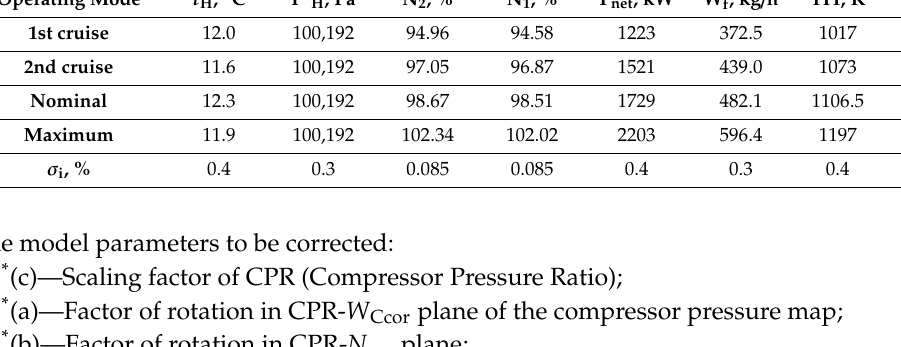
Table 1. Parameters acquired during bench testing.